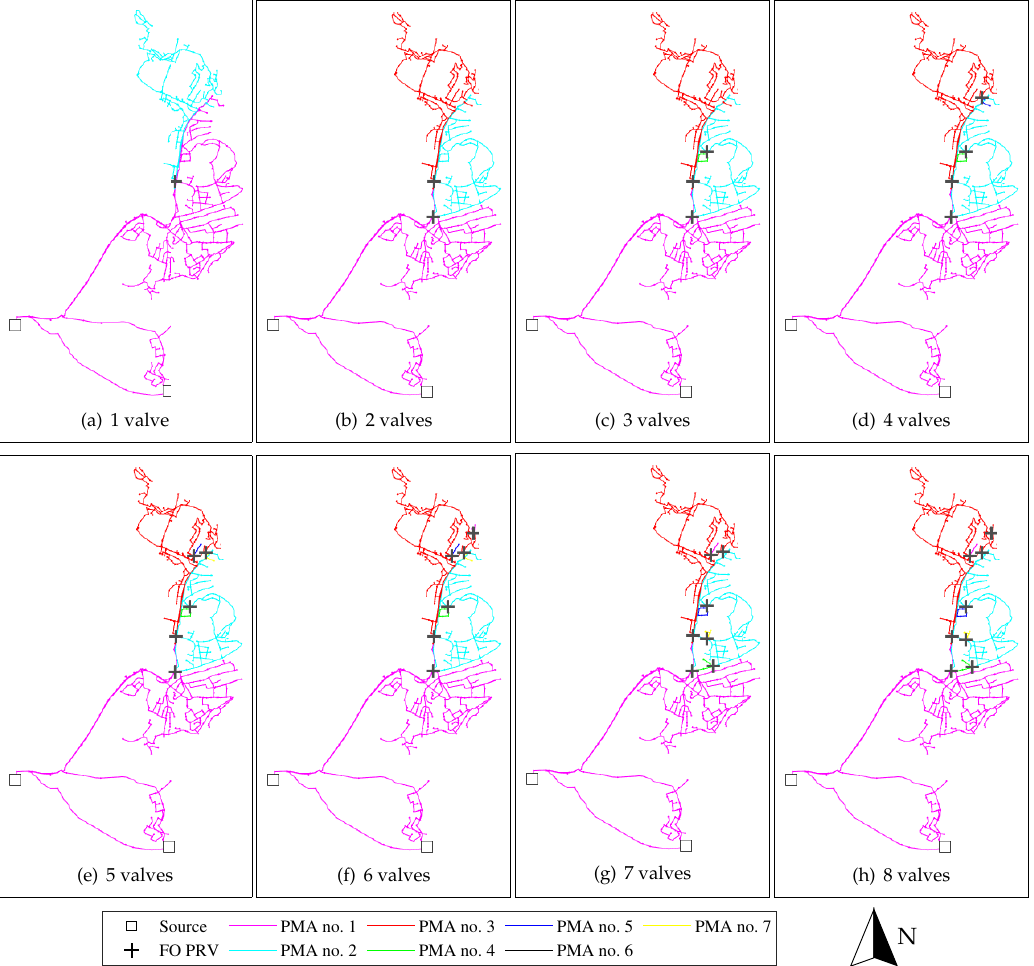
Figure 4. Optimal partitioning for 1-8 valves in example zone (no. 106), assuming only FO PRVs.